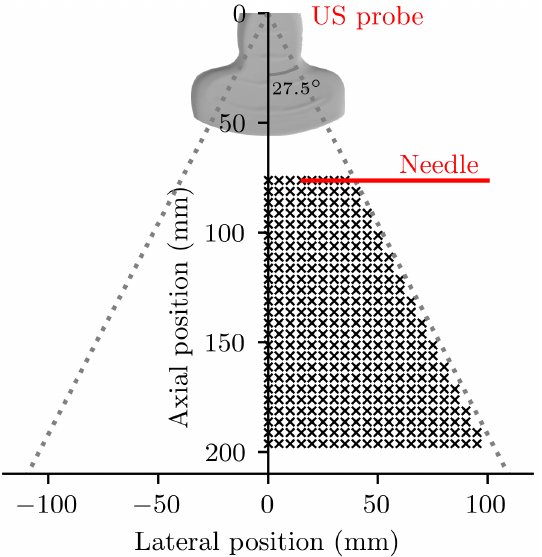
Figure 5. Diagram of the in-plane, homogenous medium in vitro accuracy experiment. Dotted lines indicate the extent of the field of view of the US imaging probe. Black crosses identify the locations at which tracking accuracy was